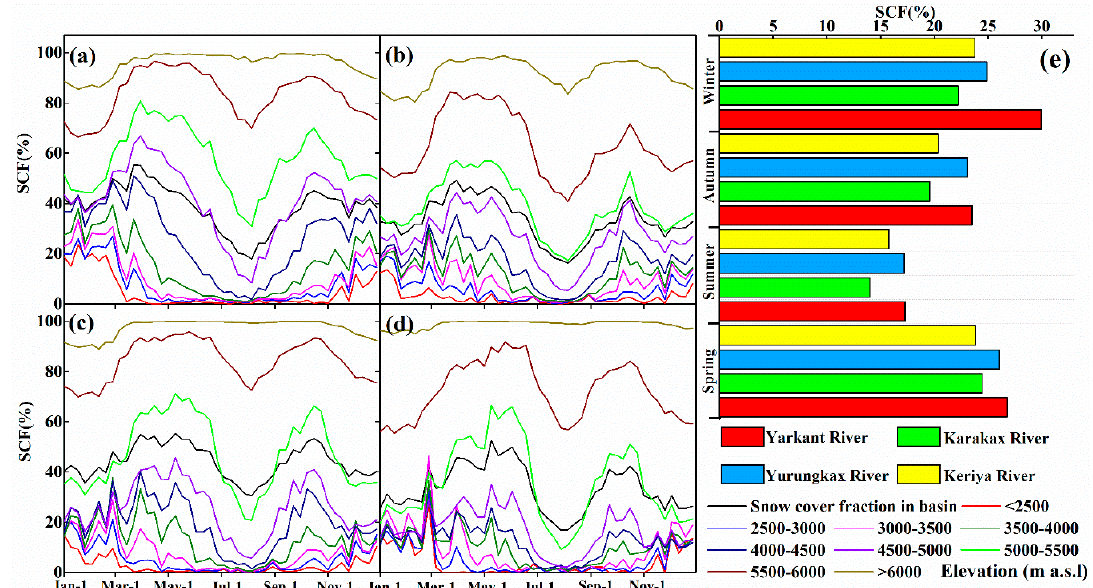
Figure 8. Snow-cover fraction (SCF) of the ( a ) YRK, ( b ) KRK, ( c ) YUK, and ( d ) KRY at different altitudes in 2001–2016. ( e ) Seasonal SCF variation in these basins. Spring: March to May; summer: